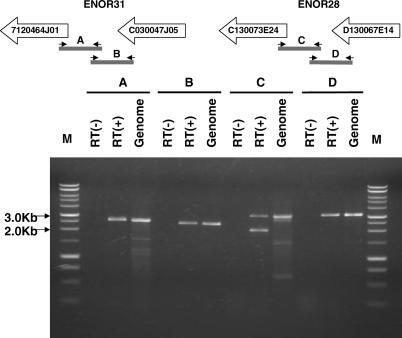
Presence of Transcription between Adjacent cDNAsPCR was carried out with and without reverse transcription (RT[+] and RT[−], respectively) using midbrain total RNA and the corresponding primer pairs (see Table S3). PCR using genomic DNA was also carried out as a control. A DNA ladder (Promega; http://www.promega.com) was used as a size marker. The amplified fragments were confirmed as the expected ones by analyzing digestion pattern using several restriction enzymes. The lower band, observed in the RT(+) lane of the amplified fragment C, seems to be nonspecific, because it was amplified using only the right primer and because it showed a digestion pattern with restriction enzymes quite different from that of the upper band and the band of the genomic DNA (unpublished data).